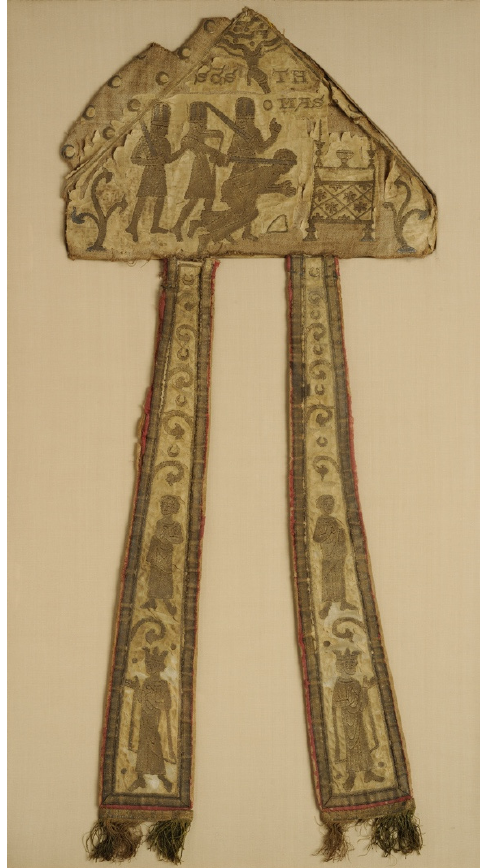
Figure 1. Jacques de Vitry’s Mitre, front face, early 13th century. Donated by the Sisters of Notre- Dame de Namur, coll. King Baudouin Foundation, on deposit at the Société Archéologique of Namur and exhibited at the TreM.a—Musée des Arts Anciens, Namur, Belgium © Hughes Dubois.